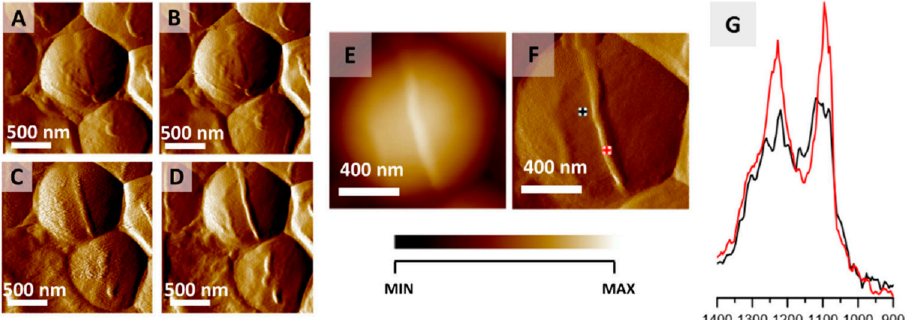
Figure 16. Monitoring S. aureus cell division via AFM-IR. ( A – D ) AFM images of S. aureus cell showing the formation of septum preceding cell division. Size of imaged area: 2 × 2 µ m. The images were selected from a larger series (12 images recorded every 20 min) and represent data recorded every 40 min. ( E , F ) AFM height and deflection image recorded at the end of cell septum formation with marked points of collection of AFM-IR spectra. Size of the imaged area 1.17 × 1.15 µ m. The height of the newly formed structure is 45 nm. ( G ) AFM-IR spectra recorded from cell area (black) and septum area (red) (marked in ( F )), in the range 1400–900 cm − 1 . Both spectra were normalized to the amide I band and demonstrate an increase in the relative intensity of cell wall components from the septum.